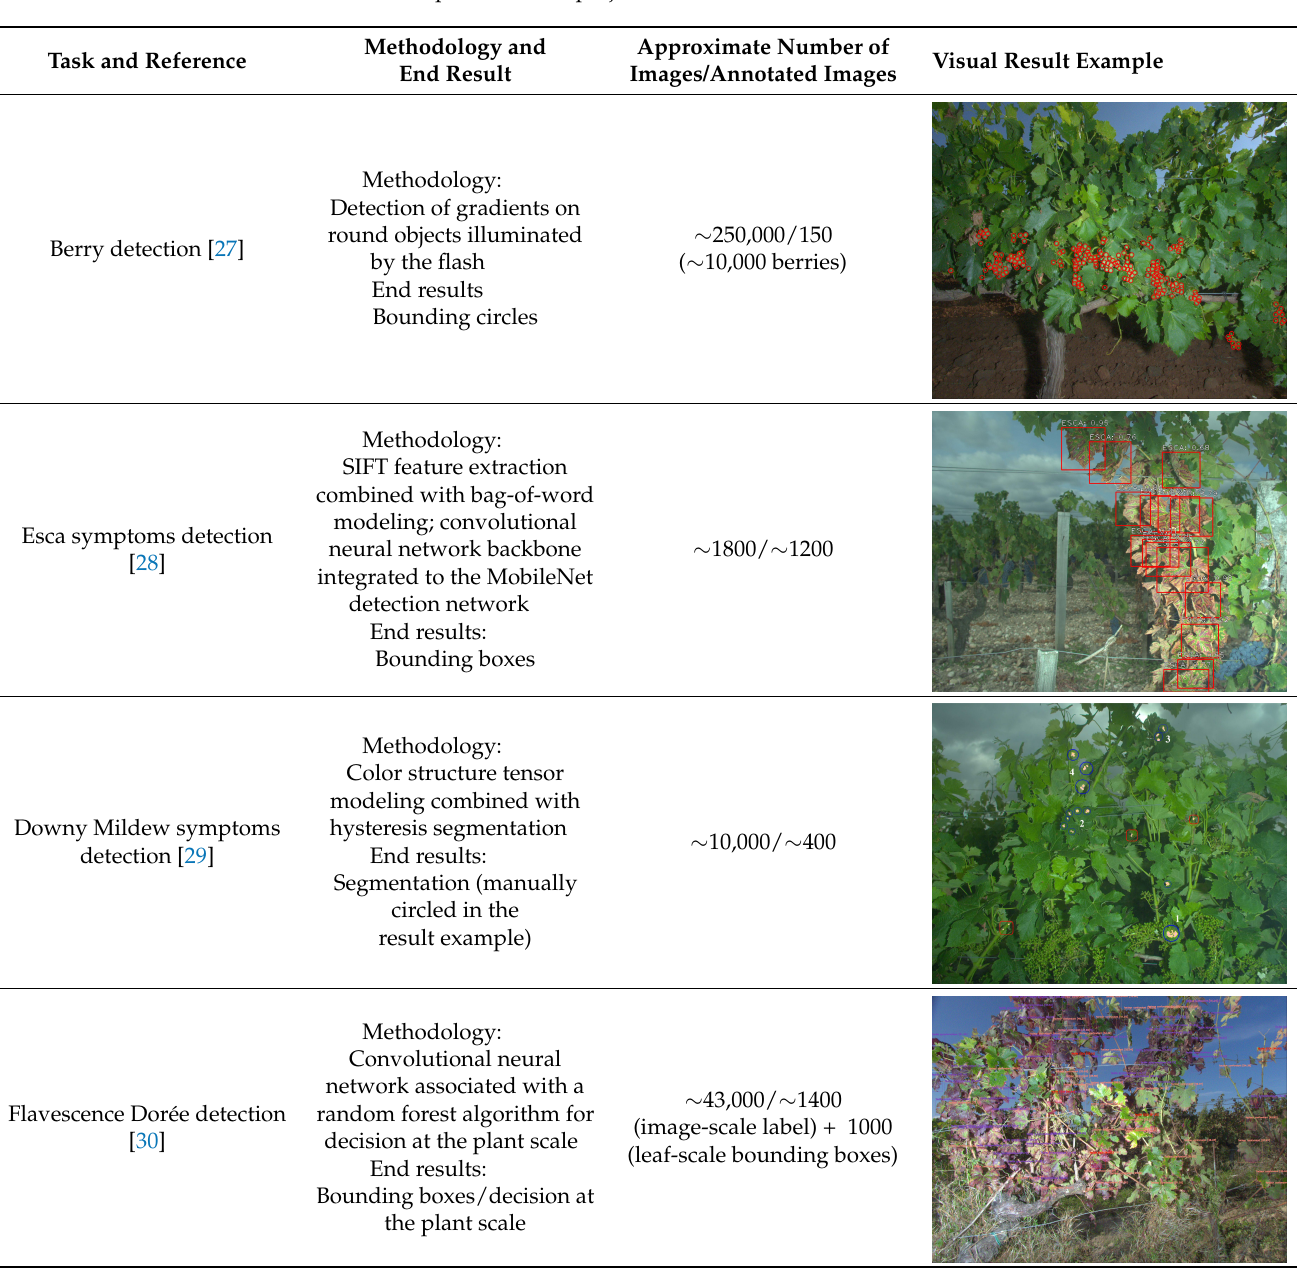
Table 2. Methodological detail of the algorithms used to process the images acquired by the experi- mental setup on different